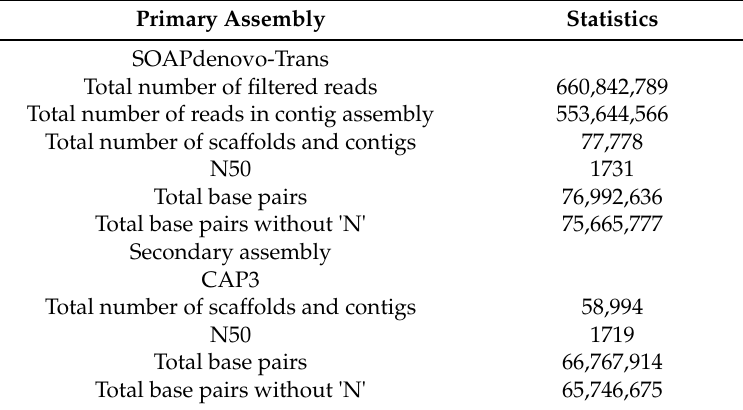
Table 1. Overview of sequencing outputs and